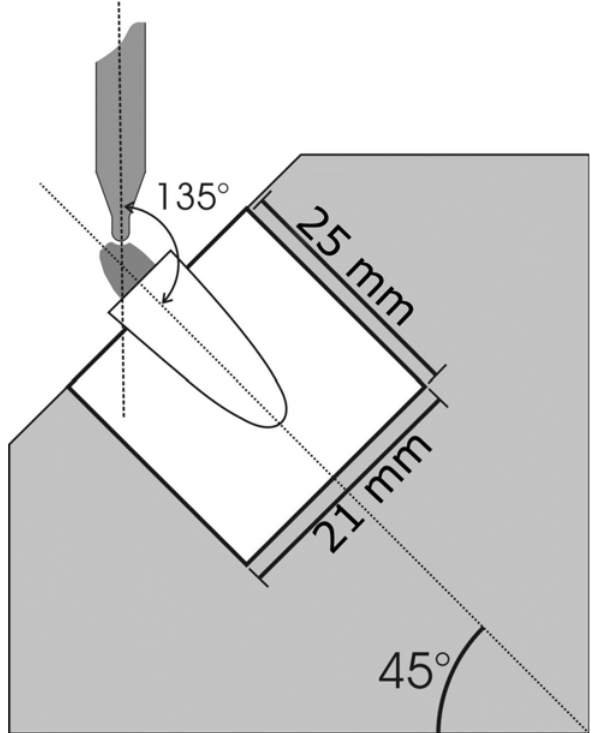
FIGURE 2- Cylindrical device used for fixation and positioning of the specimens subjected to fracture strength testing. Device positioned for load application at